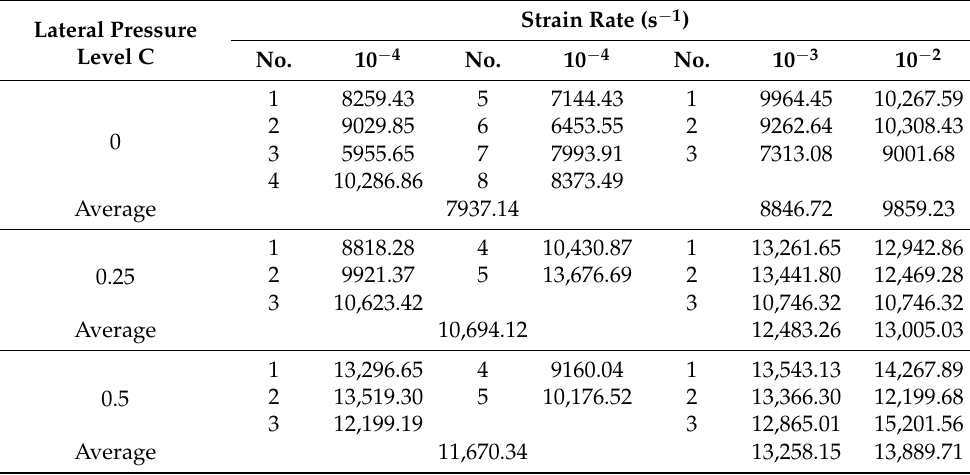
Table 7. ECC peak strain under different lateral pressure and different strain rates ( µε